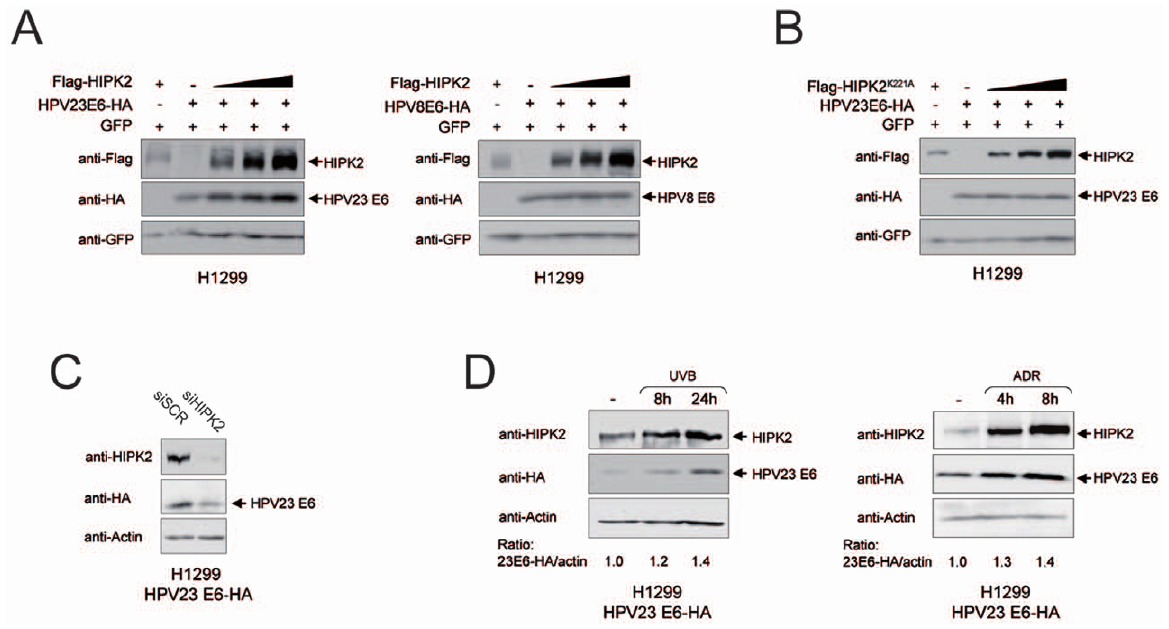
Figure 5. Accumulation of HPV23 E6 protein is caused by HIPK2. ( A–B ) Western blot analyses of H1299 cells, which were co-transfected with HA-tagged E6 of HPV23 (beta2PV) or HPV8 (beta1PV) and/or Flag-tagged HIPK2 and/or the kinase-deficient mutant HIPK2 K221A . To monitor equal transfection efficiency GFP was used as internal control. ( A ) Increasing HIPK2 levels causes accumulation of exclusively HPV23 E6 proteins, and no accumulation of HPV8 E6 proteins. ( B ) The kinase-deficient mutant HIPK2 K221A does not cause accumulation of HPV23 E6 proteins indicating that the kinase activity is essential for E6 protein accumulation. ( C ) Inhibition of HIPK2 expression in stably HPV23 E6 expressing H1299 cells by specific RNAi siHIPK2 (negative control siScr). Reduction of HIPK2 protein caused a decrease of E6 protein levels shown by Western blot analysis. ( D ) Stably HPV23 E6 expressing H1299 cells were treated with lethal UVB doses (1,000 J/m 2 ) or adriamycin (0.5 m g/ml; ADR) and examined by Western blot. The amount of E6 proteins was quantified using the Odysse software. Activated endogenous HIPK2 upon DNA damage (8 h and 24 h after UVB-radiation, left panel; or 4 h and 8 h after ADR treatment, right panel) caused accumulation of HPV23 E6 proteins. The quantified amounts of HPV23 E6 proteins are shown as the ratio of HPV23